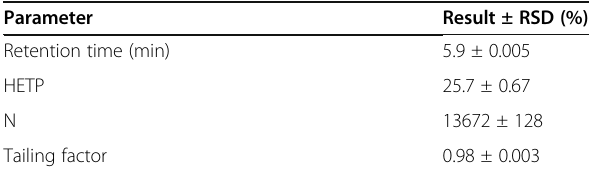
Table 7 System suitability parameters